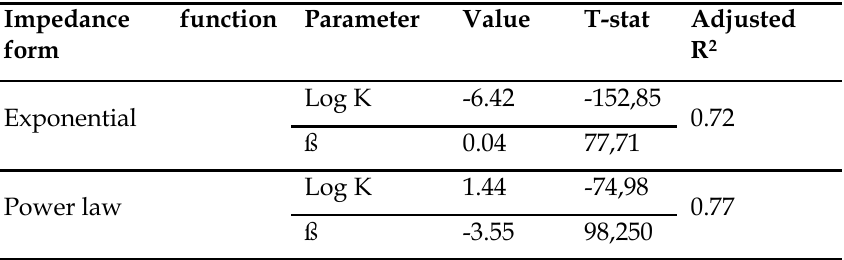
Table 3. Unconstrained SIM models: statistics of the